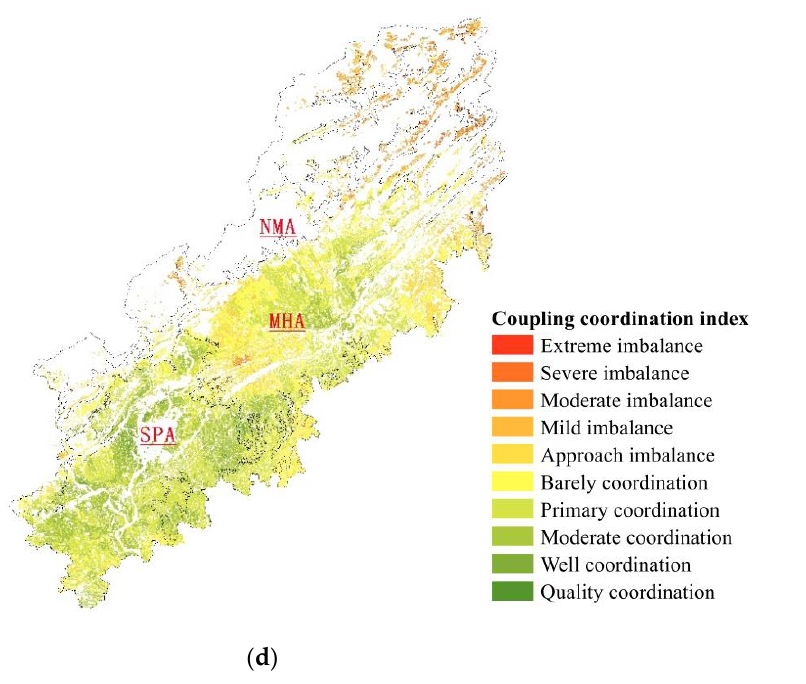
Figure 3. The map of the coupling coordination index of PA-SA ( a ), PA-HA ( b ), SA-HA ( c ) and PA-SA-HA ( d ).